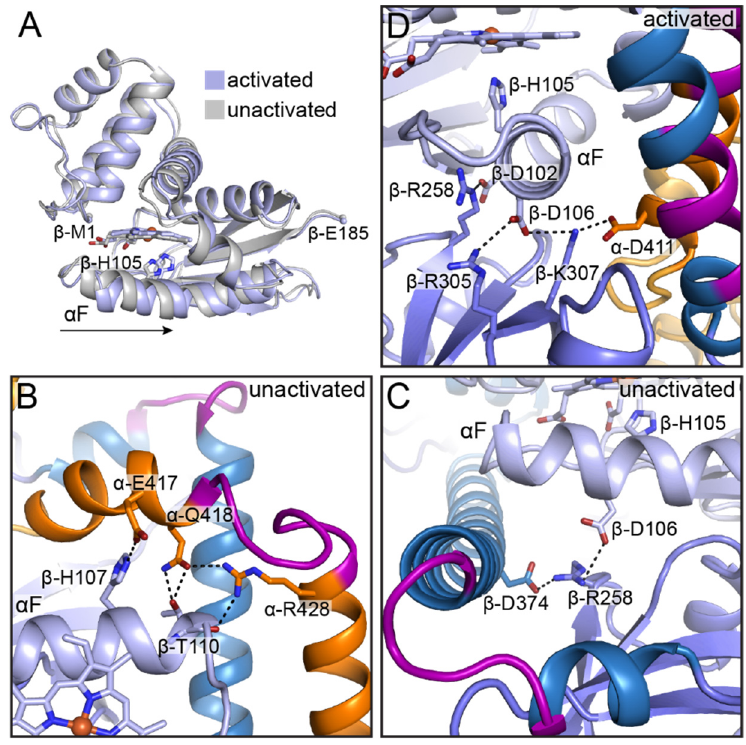
Figure 6. Structural rearrangements in the β H-NOX α F helix occur upon activation. ( A ) Superposition of the β H-NOX domains in the unactivated (grey, PDB ID 6JT0 [65]) and activated (light blue, PDB ID 6JT2 [65]) states. Activation induces a lateral shift of the α F helix, as indicated by the black arrow. Structures were aligned by least squares fitting by the β -sheet region of the proximal subdomain (r.m.s.d. = 0.70 Å for 67 C α atoms). ( B ) In the unactivated state, residues within the α F helix make contact with residues in the α CC domain. ( C ) In the unactivated state, β -Asp106 on the α F helix participates in an interaction network with β -Arg258 in the β PAS domain and β -Asp374 in the β CC domain. The α sGC subunit has been omitted from this panel for clarity. ( D ) In the activated state, residues along the α F helix make different contacts than in the unactivated state. Domains are colored as in Figure 4 with the heme C atoms in light blue. Amino acid side chains are shown as sticks with C in respective domain colors, N in blue, and O in red. Hydrogen bonding interactions are shown as black dashes. The N- and C-terminal residues of the β H-NOX domain are labeled and shown as small spheres in panel